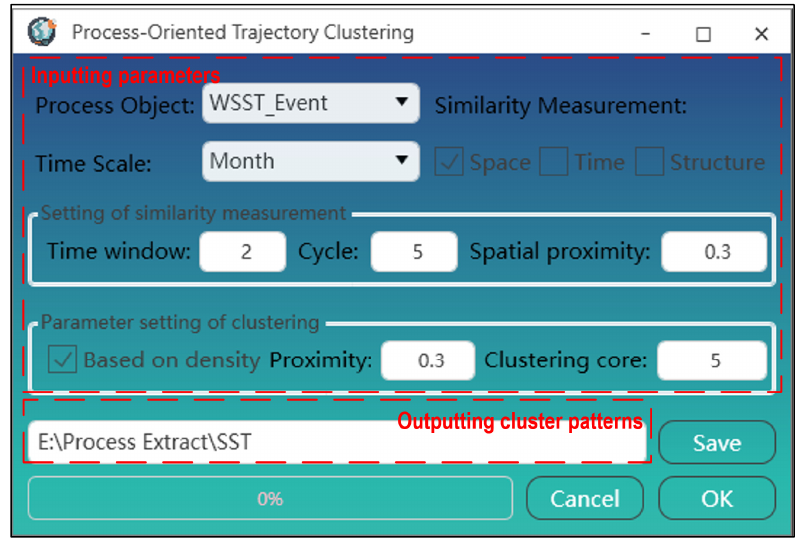
Figure 13. Interface of process-oriented clustering function.